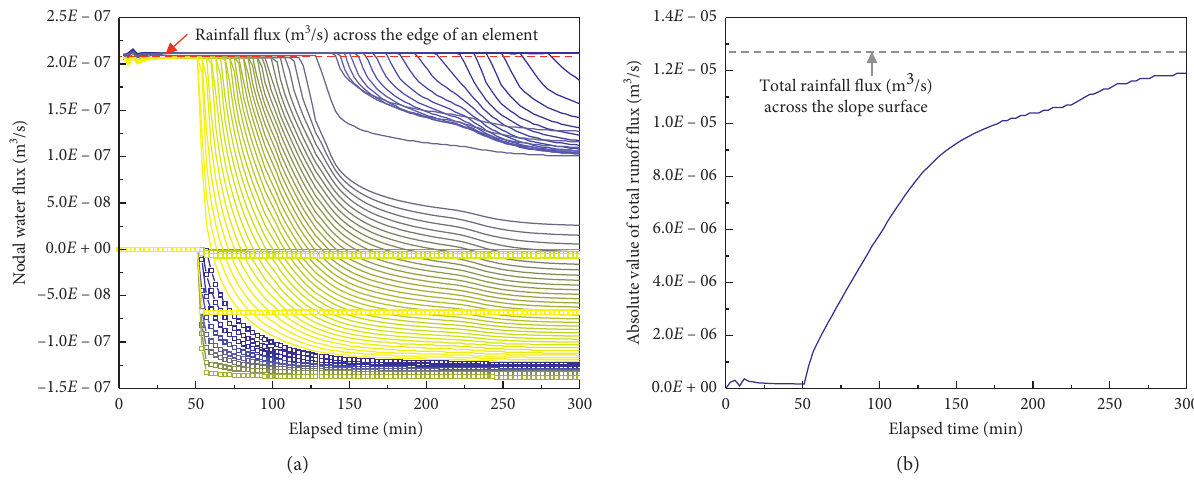
Figure 9: Change in comprehensive water flow across boundaries (i.e., slope surface) over time. (a) Individual nodal flow. (b) Total runoff flow. ∗ The group of line plots are from the rainfall flux boundary nodes, whereas the group of “line and symbol” plots are from the seepage face boundary nodes (refer to Figure 5 for the two boundary section). ∗∗ On a color spectrum from blue to yellow, the darkest blue line indicates a node at the highest elevation, whereas the brightest yellow line indicates a node at the lowest elevation. The color spectrum is applied to the two groups of plots